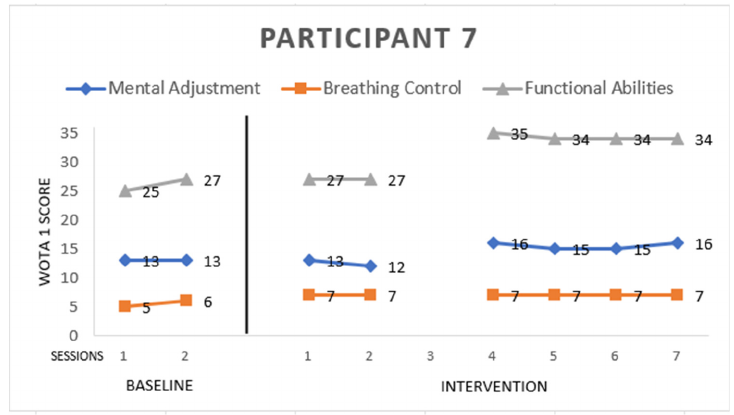
Figure 6. Highest possible scores: Mental Adjustment = 16, Breathing Control = 8, Functional Abilities = 36.